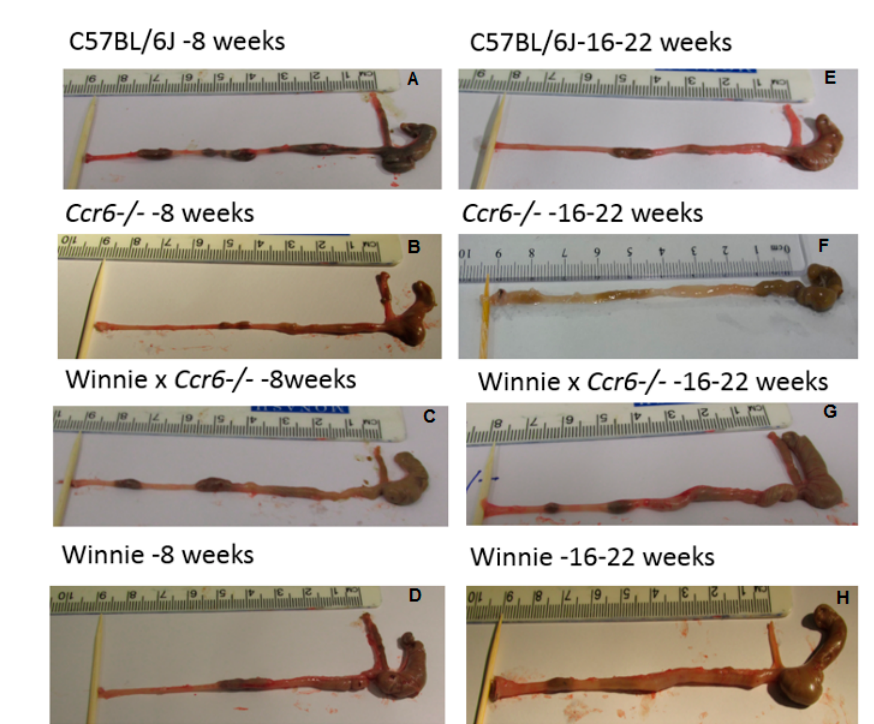
Figure 2. Of gross colon morphology in freshly removed colons measured from the ileo-caecal junction to the anus and before cutting open along the longitudinal axis and luminal contents removed in the four genotypes (WT, Ccr6 − / − , Winnie × Ccr6 − / − and Winnie) at 8 weeks ( A – D ) and 16–22 weeks ( E – H ) of age. Magnification ×1.